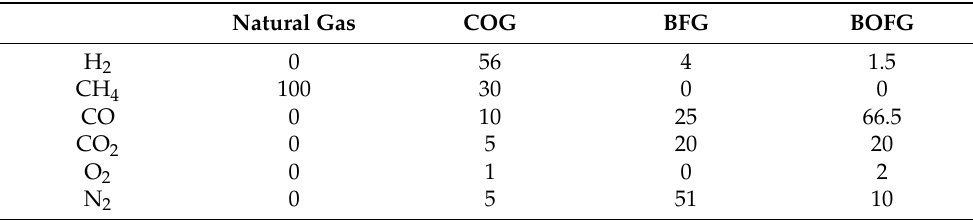
Table 1. Elemental composition considered for the fuel gases produced as by-products in the ironmaking plant (vol %), according to the ranges reported in [3].